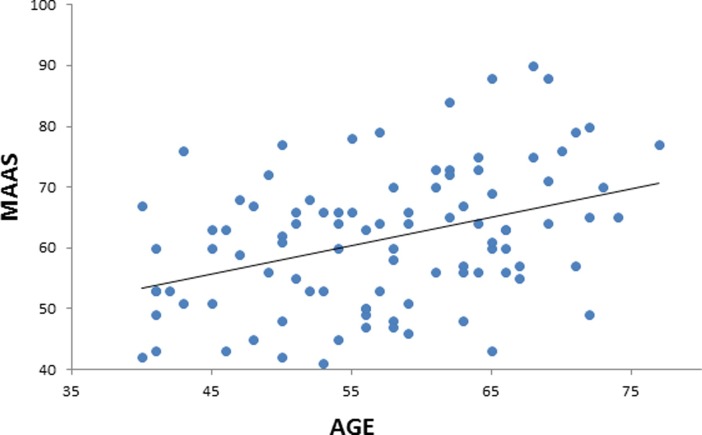
Positive correlation between age and mindfulness assessed by the mindful attention awareness scale (MAAS).Scatterplot with regression line.